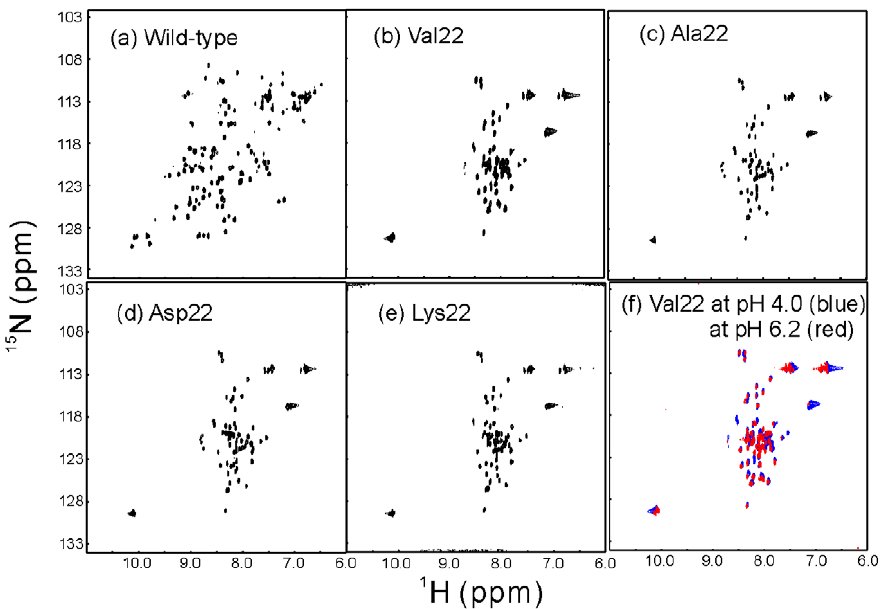
Figure 3. NMR characterization. 1 H- 15 N NMR HSQC spectra of the wild-type SH3 and its insertion mutants with protein concentrations of , 100 m M acquired on an 800 MHz NMR spectrometer at 25 u C. The wild-type SH3 was dissolved in 5 mM phosphate buffer (pH 6.2) while the insertion mutant were solubilized in salt-free water (pH 4.0). (f). Superimposition of the HSQC spectra of V22-SH3 at pH 4.0 (blue) and at pH 6.2 (red).